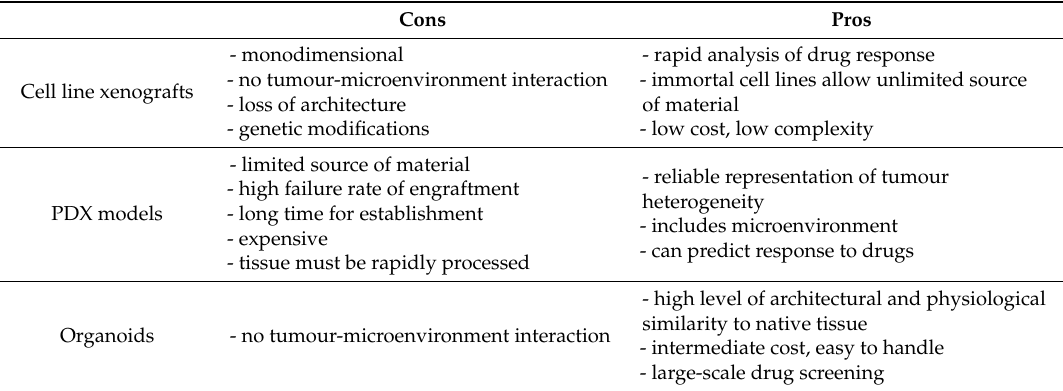
Table 3. Patient-derived preclinical models of GC: advantages and